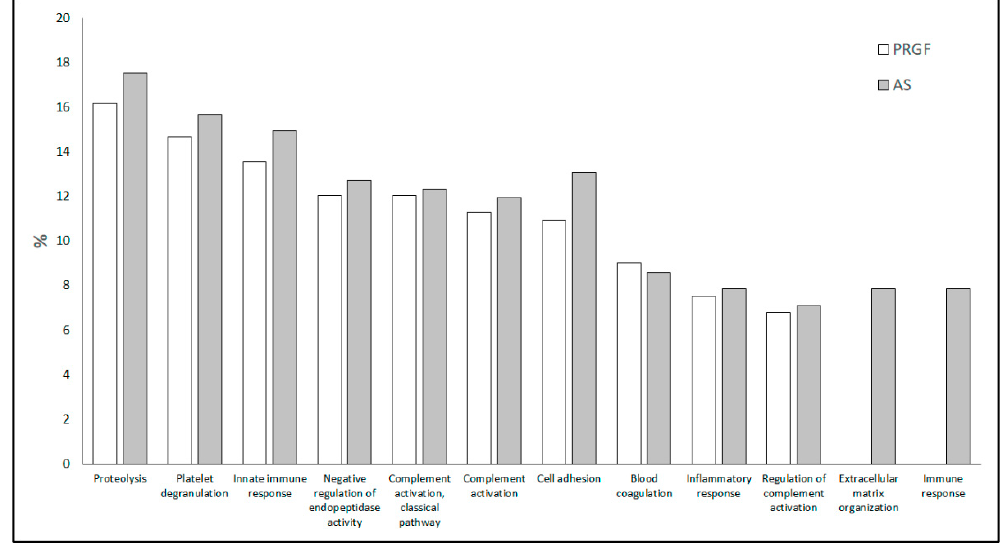
Figure 2. The ten most abundant Gene Ontology terms identified in PRGF and AS formulations, and two of the processes that were only found in AS formulation, which were related to extracellular matrix organization and immune response.